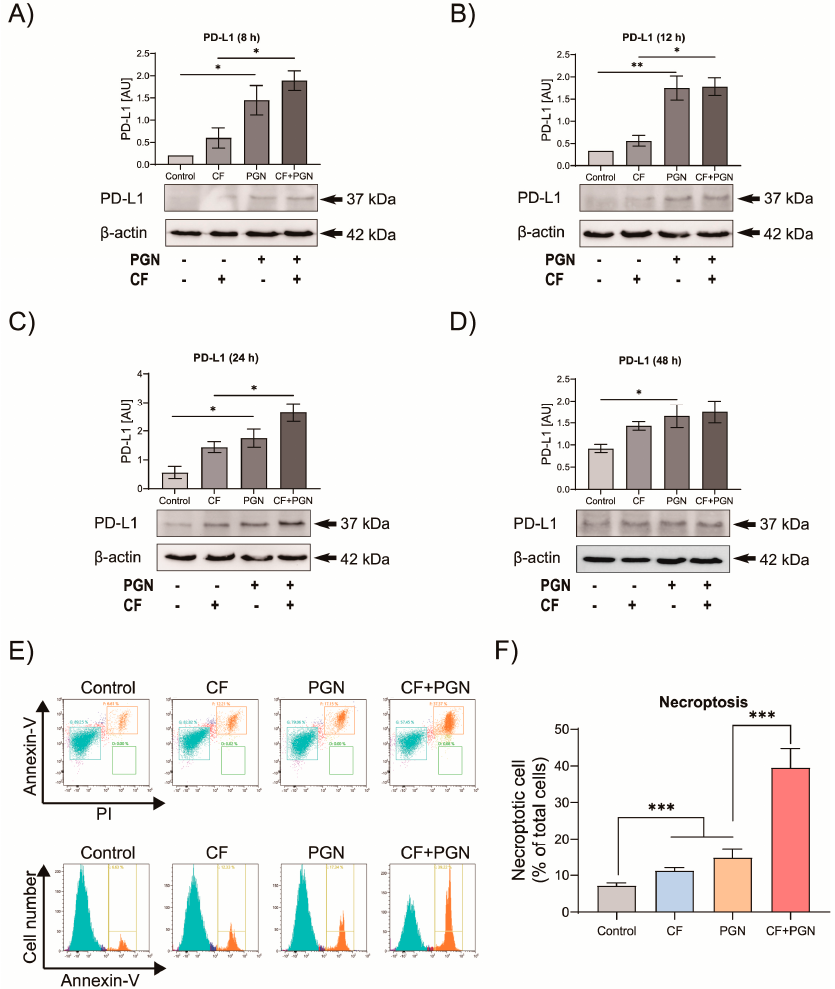
Figure 3. Compressive force as well as P. gingivalis PGN trigger PD-L1 expression and participate in the necroptosis regulation. Cementoblasts were treated with the established concentration of P.